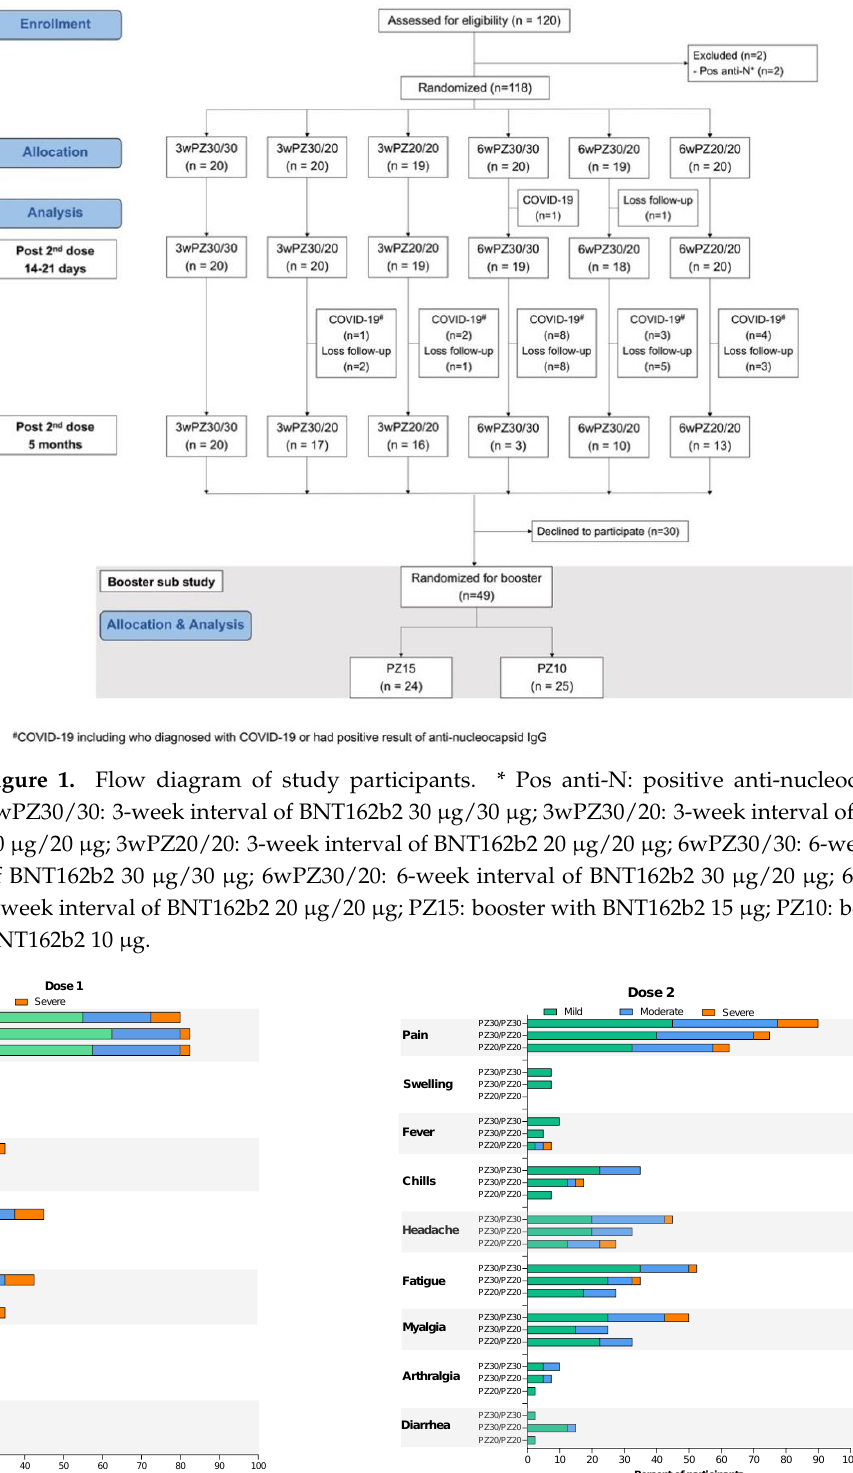
Figure 2. Solicited reactogenicity during 7 days after BNT162b2 primary series vaccination in healthy adolescents, by vaccination groups: ( A ) post the first dose of BNT162b2 and ( B ) post the second dose of BNT162b2.